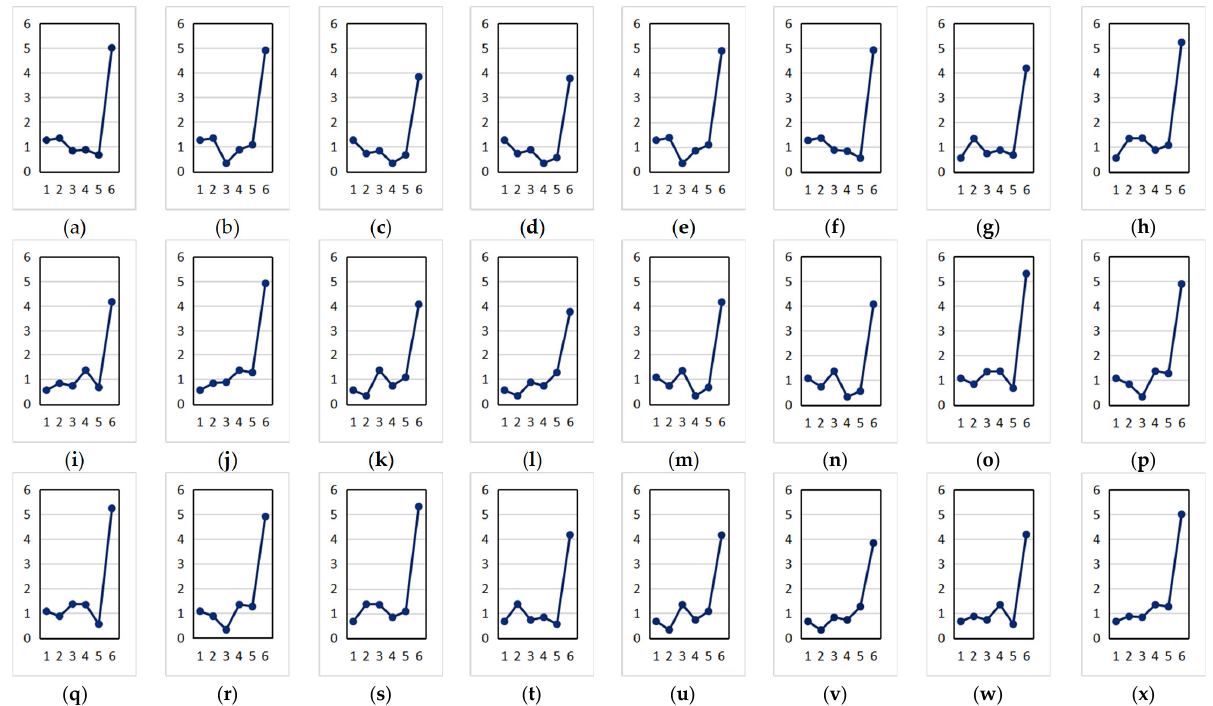
Figure 13. The increasing tendency of the weight g ( Z ) of each tour route tourist attraction adjacency section o ( R to ( i ) , R to ( j ) ) under the condition of transportation mode of using the public bus. The figure ( a – x ) represent the No.1~No.24 tour routes shown in the Table 6 under the condition of transportation mode of using the public bus τ =